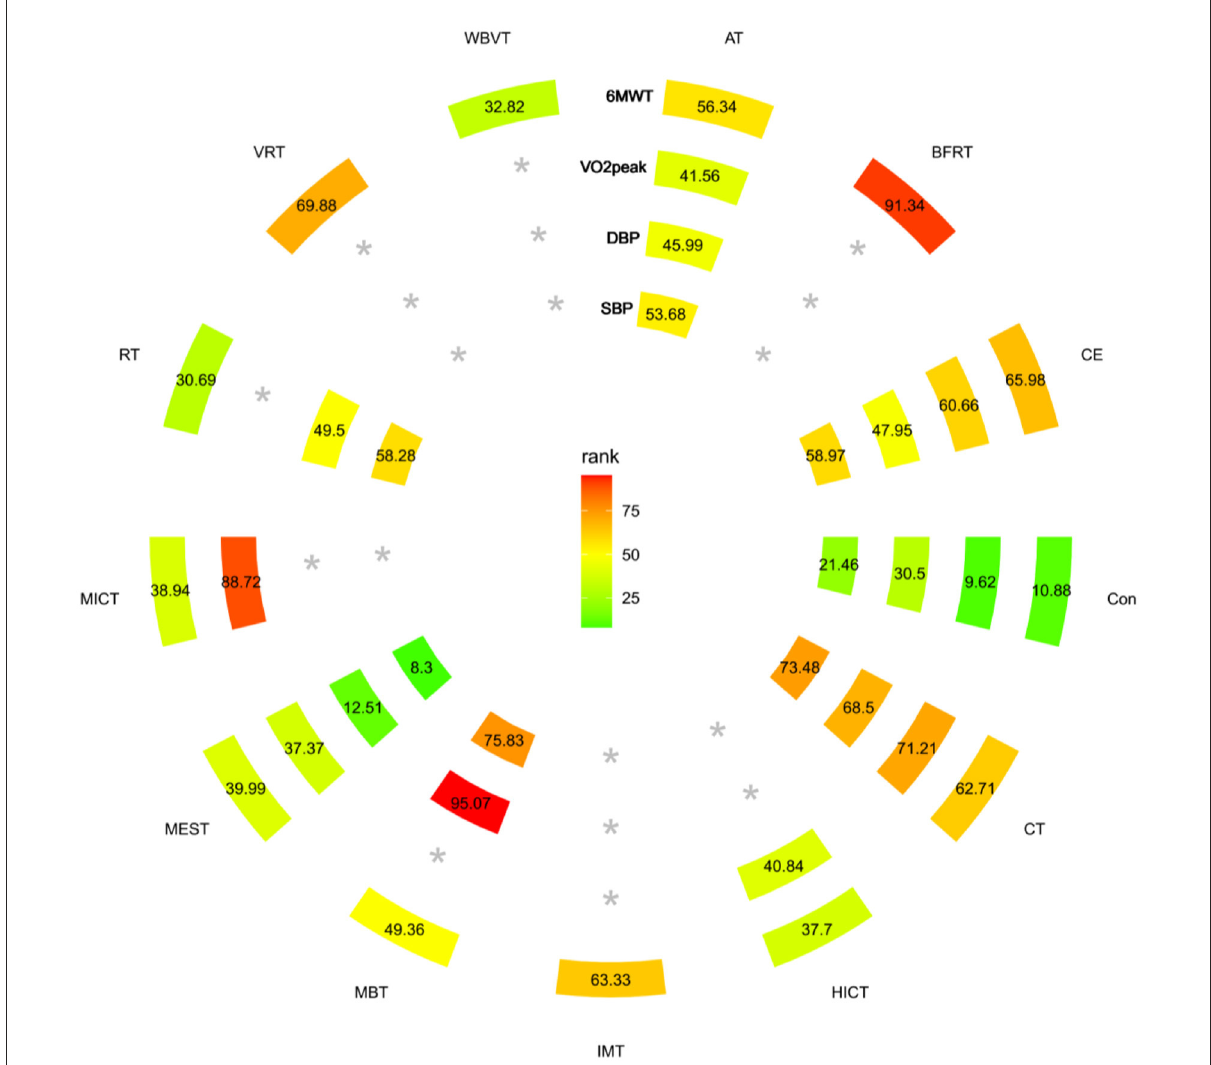
FIGURE3 Heat map ranked according to the degree of relevant change in 6WMT, VO 2 Peak, SBP, and DBP parameters. The numbers reflect the P -score, ranked continuously from 0 to 1. A higher SUCRA indicates a more significant increase in 6WMT, VO 2 Peak. In the case of blood pressure parameters, a higher SUCRA suggests a more pronounced effect on lowering blood pressure. * The exercise mode corresponding to the outcome was not included in the literature. * Treatment without data on the outcome within the